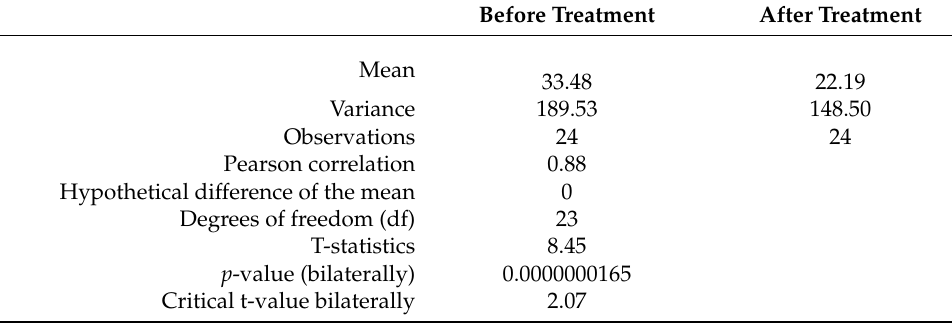
Table 3. Statistical Analysis of Vessel Lumen